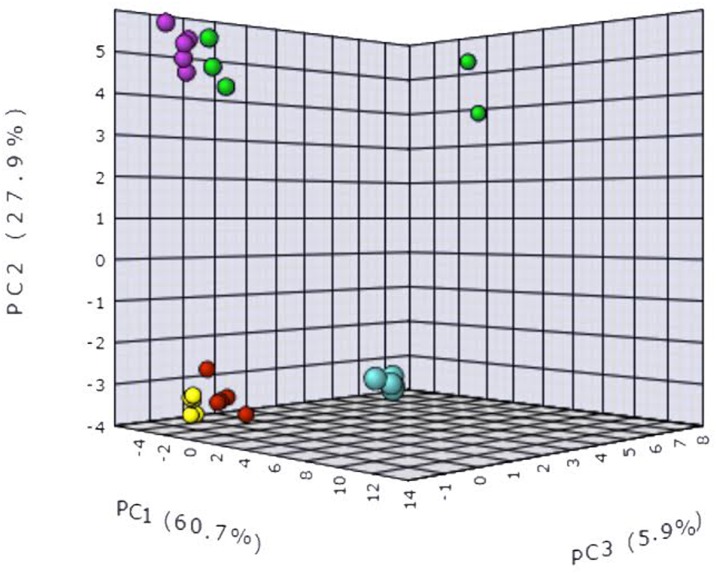
Principal component analysis according to the metabolome obtained from the composts COM-A (green balls), COM-B (pink balls), COM-C (red balls), COM-D (yellow balls), and peat (blue balls), n = 6.